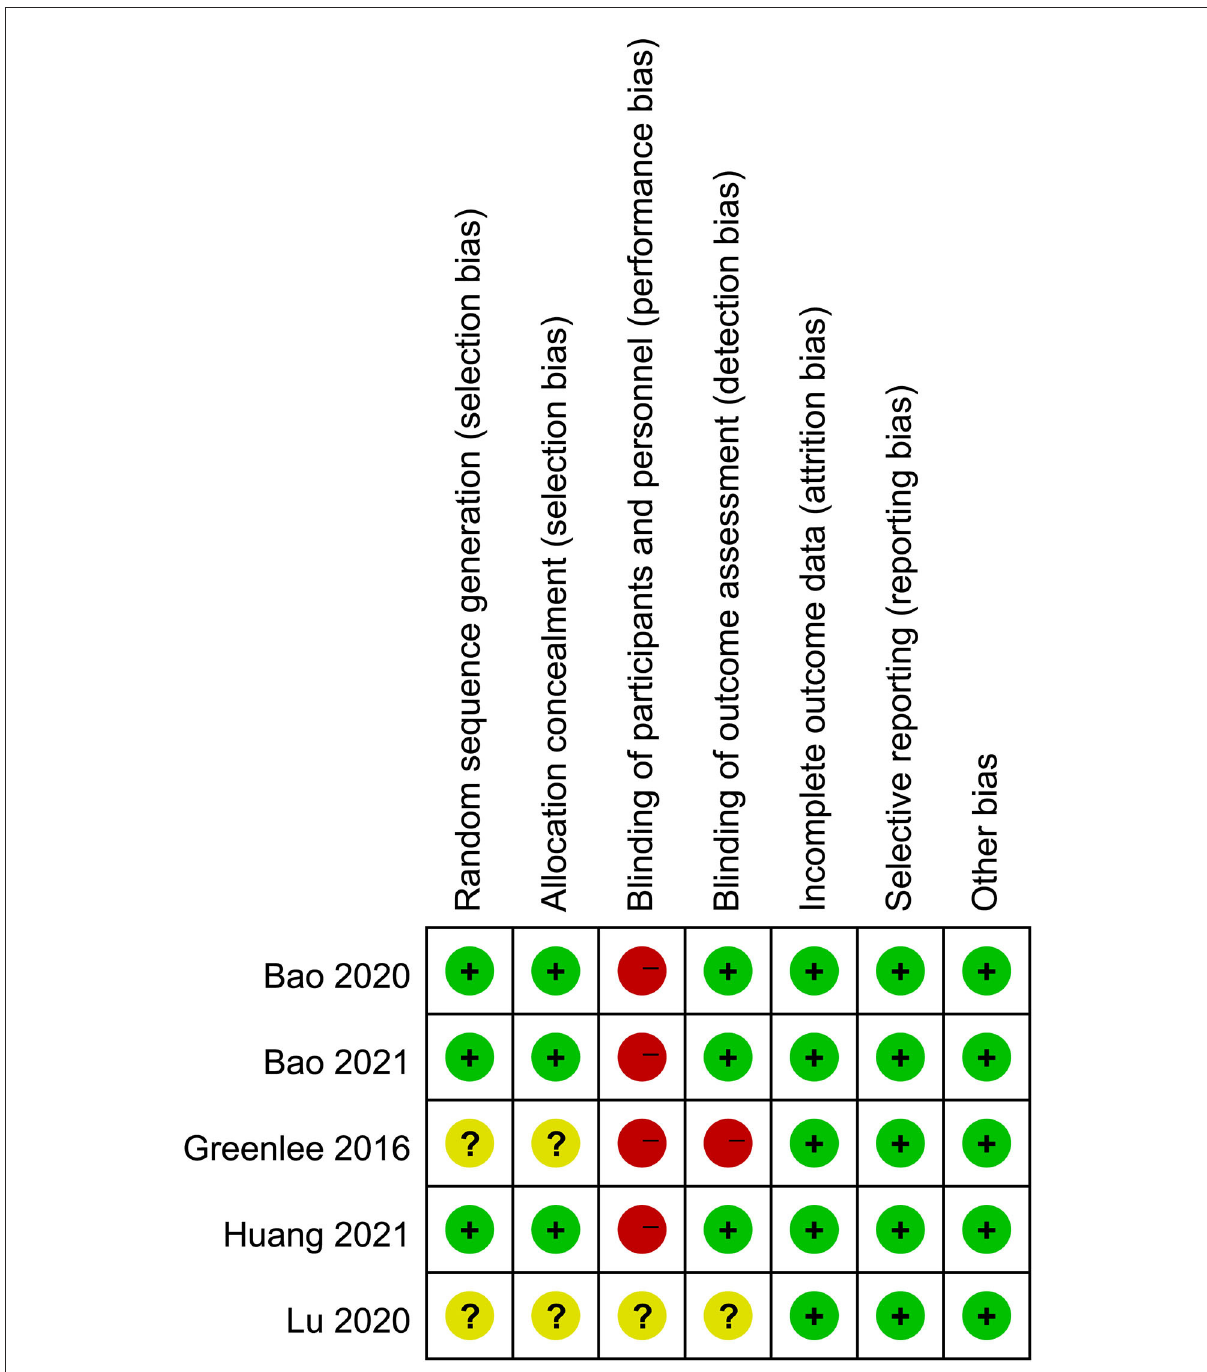
FIGURE2 Risk of bias